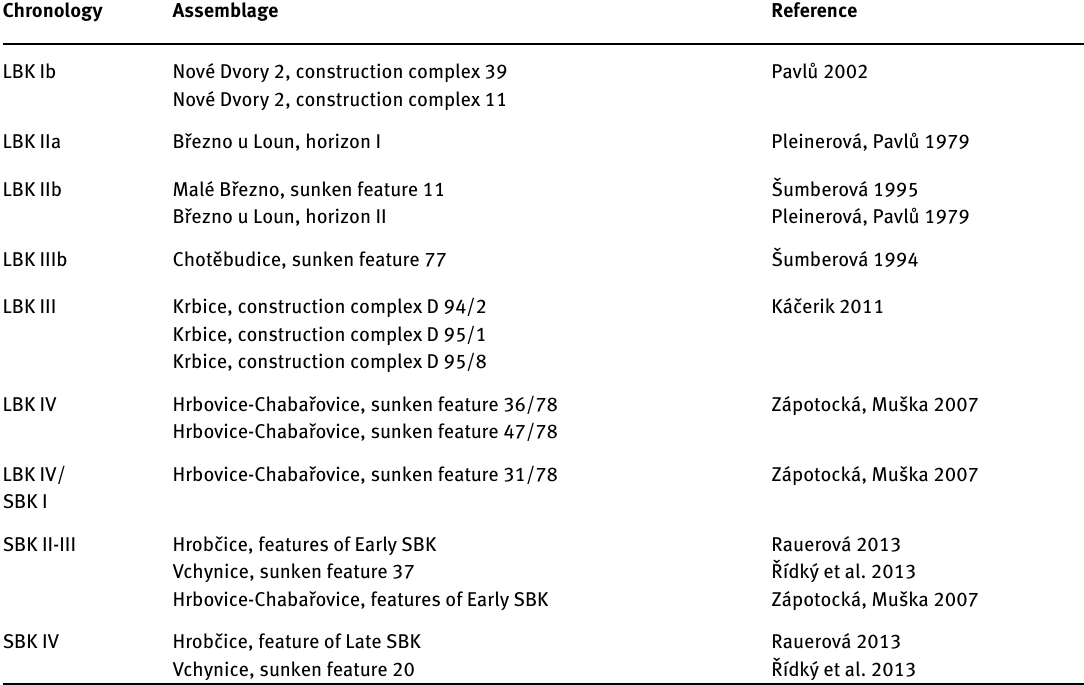
Table 1. The referential assemblages from Neolithic sites, which were used for